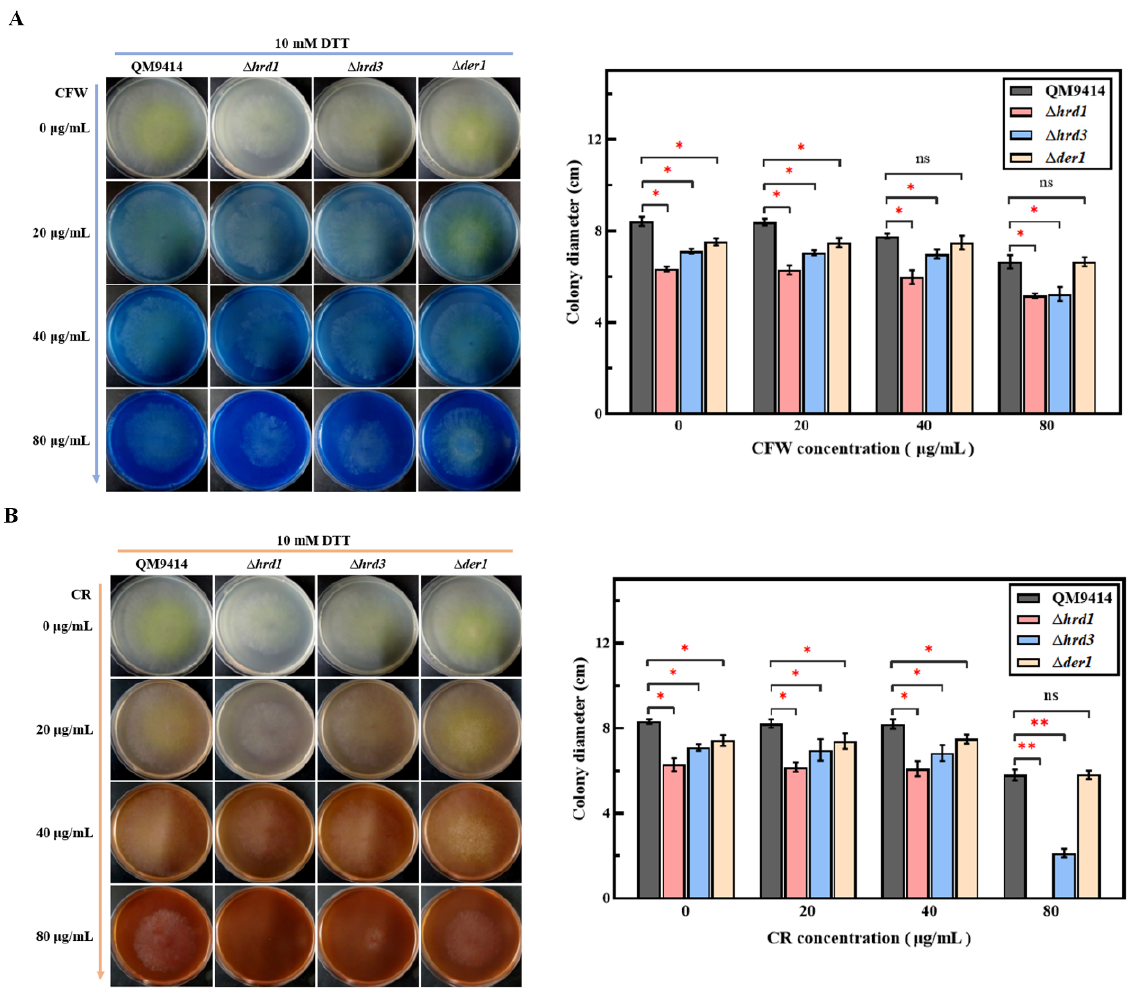
Figure 2. Cell wall stability of the ERAD-deficient mutants under ER pressure. Growth analysis of QM9414 and the ERAD-deficient mutants using the MM plates supplemented with different concentrations of Calcofluor white ( A ) or Congo red ( B ). The concentrations of CFW or CR were 0, 20, 40, and 80 µg/mL, respectively. All plates contained 10 mM DTT to induce ER pressure. The strains were grown on MM containing glucose as the carbon source at 30°C for 3 days, and the diameters of all colonies were measured. Values represent the mean of three repeated measurements taken from at least three parallel experiments. The error bars refer to the standard deviations. The difference between the parental strain and the knockout strains was shown by analysis of ANOVA followed by Tukey’s test. * p < 0.05; ** p < 0.01. ns, not significant.